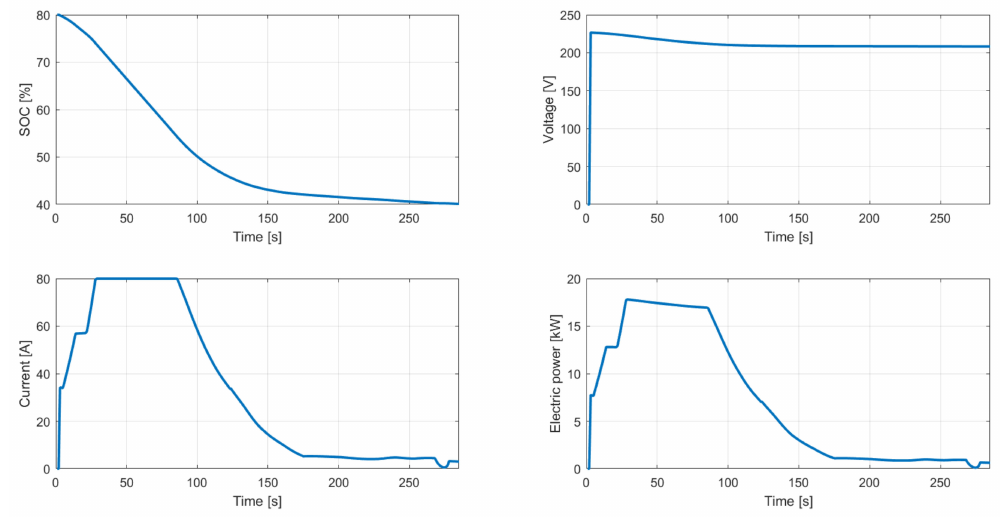
Figure 17. The behavior of the battery in the case of engine